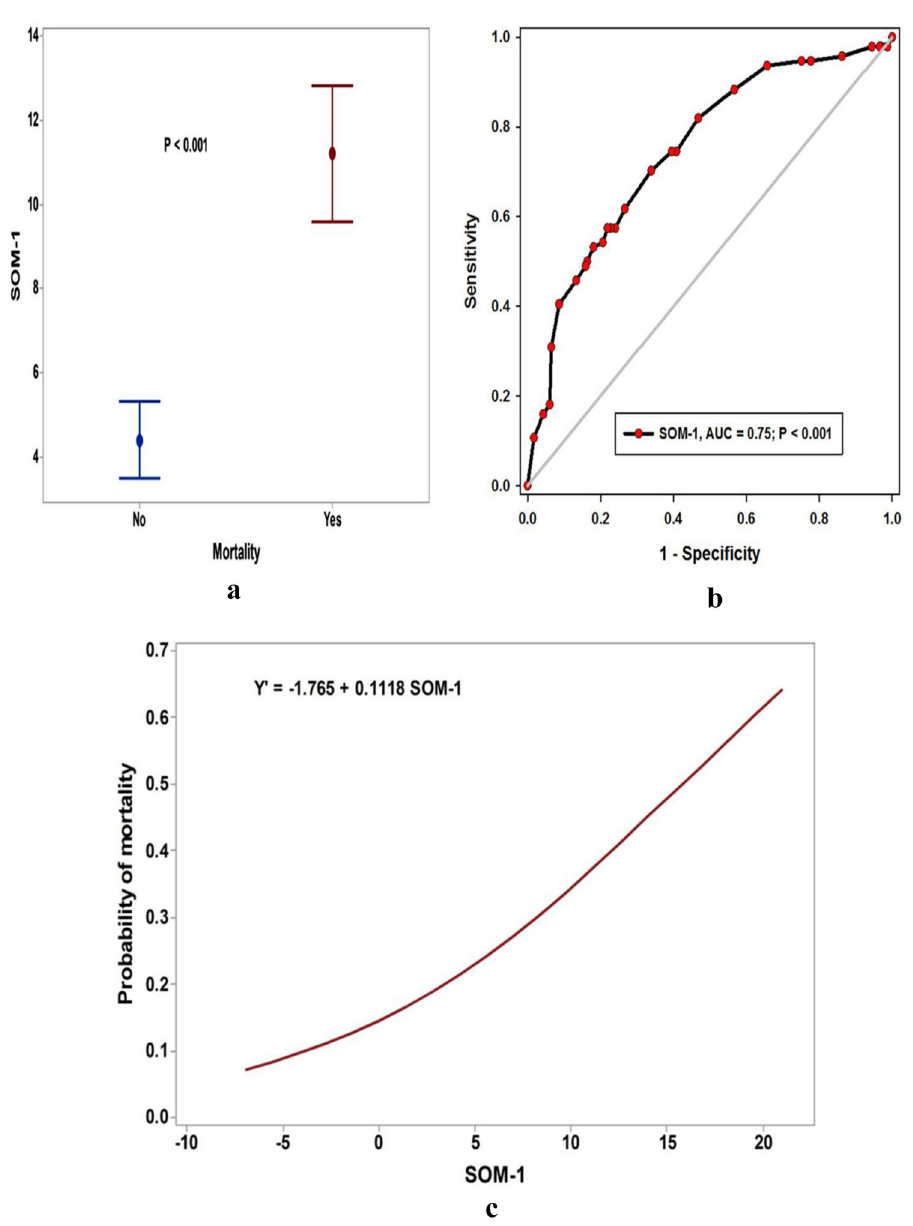
Figure 3. Score of mortality (SOM) in validating